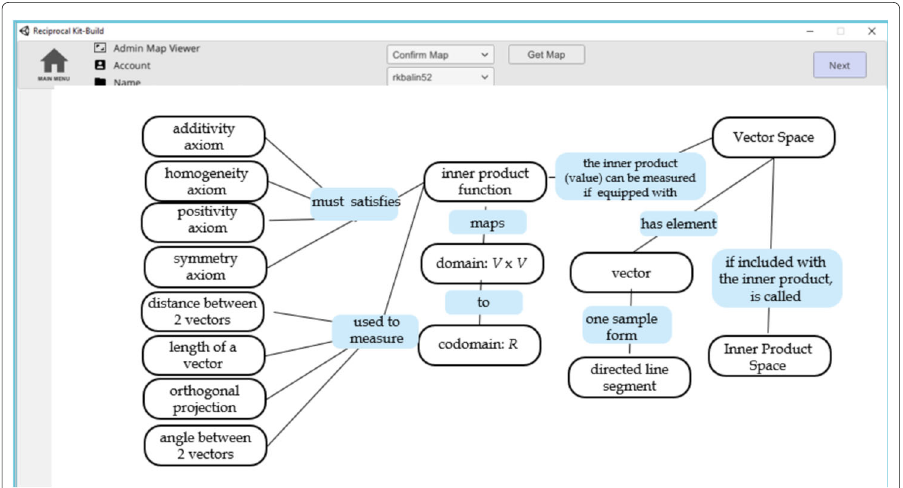
Fig. 9 Sample of a high-quality collaborative map with the score of 100. The group belongs to low-prior-knowledge-equivalence and low-shared-knowledge